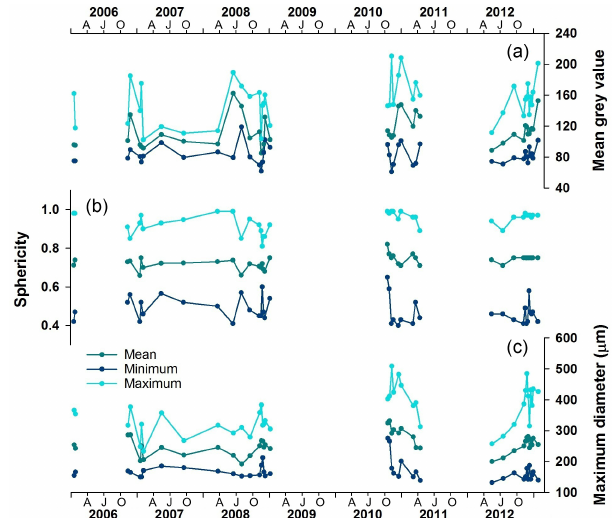
Figure 3. Time series record of the foraminiferal morphological pa- rameters collected by the automated analysis. (a) Mean grey val- ues as a measure of translucency and calcification; (b) sphericity; (c) maximum diameter. AJO: April (autumn), July (winter), Octo- ber